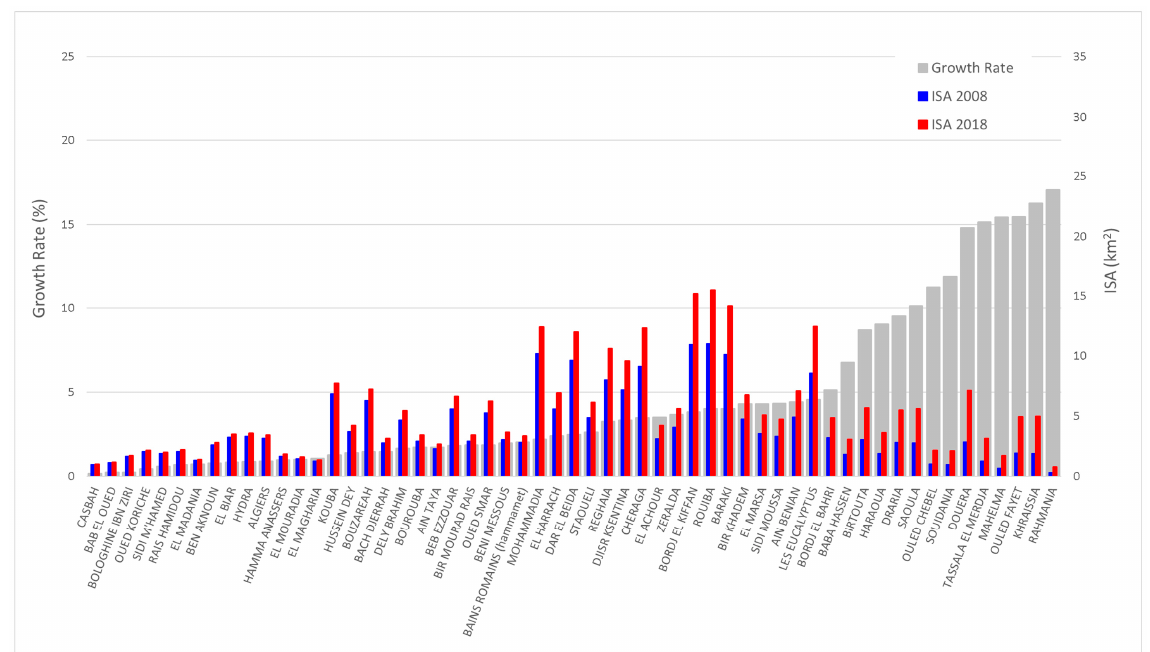
Figure 13. Impervious surface area (ISA) (km 2 ) and its growth rate (1/10 of percent) for the communes in the Algiers wilaya between 2008 and 2018.